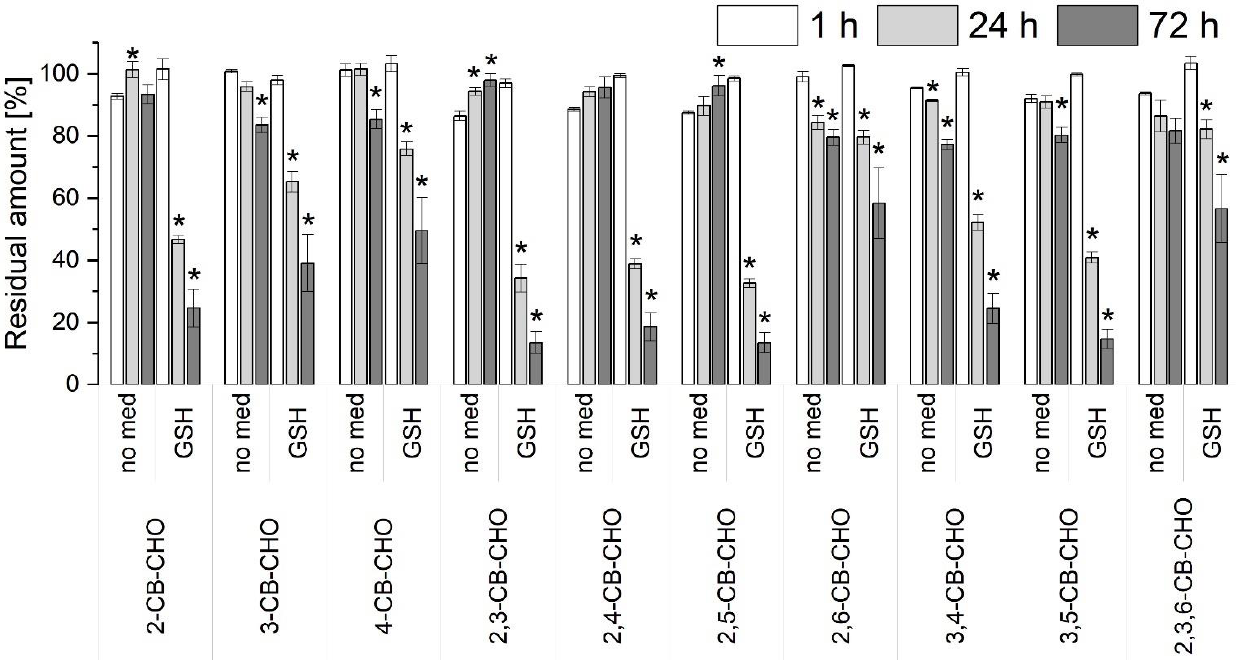
Figure 3. Residual amounts (related to corresponding heat-deactivated controls) of chlorobenzaldehydes (CB-CHOs) detected after incubation with the extracellular liquid of Irpex lacteus with no mediator (no med) or reduced glutathione (GSH): 2-chlorobenzaldehyde (2-CB-CHO); 3-chlorobenzaldehyde (3-CB-CHO); 4-chlorobenzaldehyde (4-CB-CHO); 2,3-dichlorobenzaldehyde (2,3-CB-CHO); 2,4-dichlorobenzaldehyde (2,4-CB-CHO); 2,5-dichlorobenzaldehyde (2,5-CB-CHO); 2,6-dichlorobenzaldehyde (2,6-CB-CHO); 3,4-dichlorobenzaldehyde (3,4-CB-CHO); 3,5-dichlorobenzaldehyde (3,5-CB-CHO); and 2,3,6-trichlorobenzaldehyde (2,3,6-CB-CHO). The CB-CHOs were incubated in a mixture; the initial concentration was 2 µg mL −1 for each. The initial enzyme activities were 706 U L −1 of manganese-dependent peroxidase and 114 U L −1 of manganese-independent peroxidase. The asterisks denote where significant ( p -value < 0.05) differences were found between 1 h and 24 h or between 1 h and 72 h (ANOVA and Tukey’s range test). In the nonderivatized samples after incubation of CB-CHOs with the extracellular liquid of I. lacteus , four peaks were detected with an m / z of 188 that exhibited an identical fragmentation pattern with initial losses of − 15 (CH 3 ) and − 28 (CO) (Figure S5).